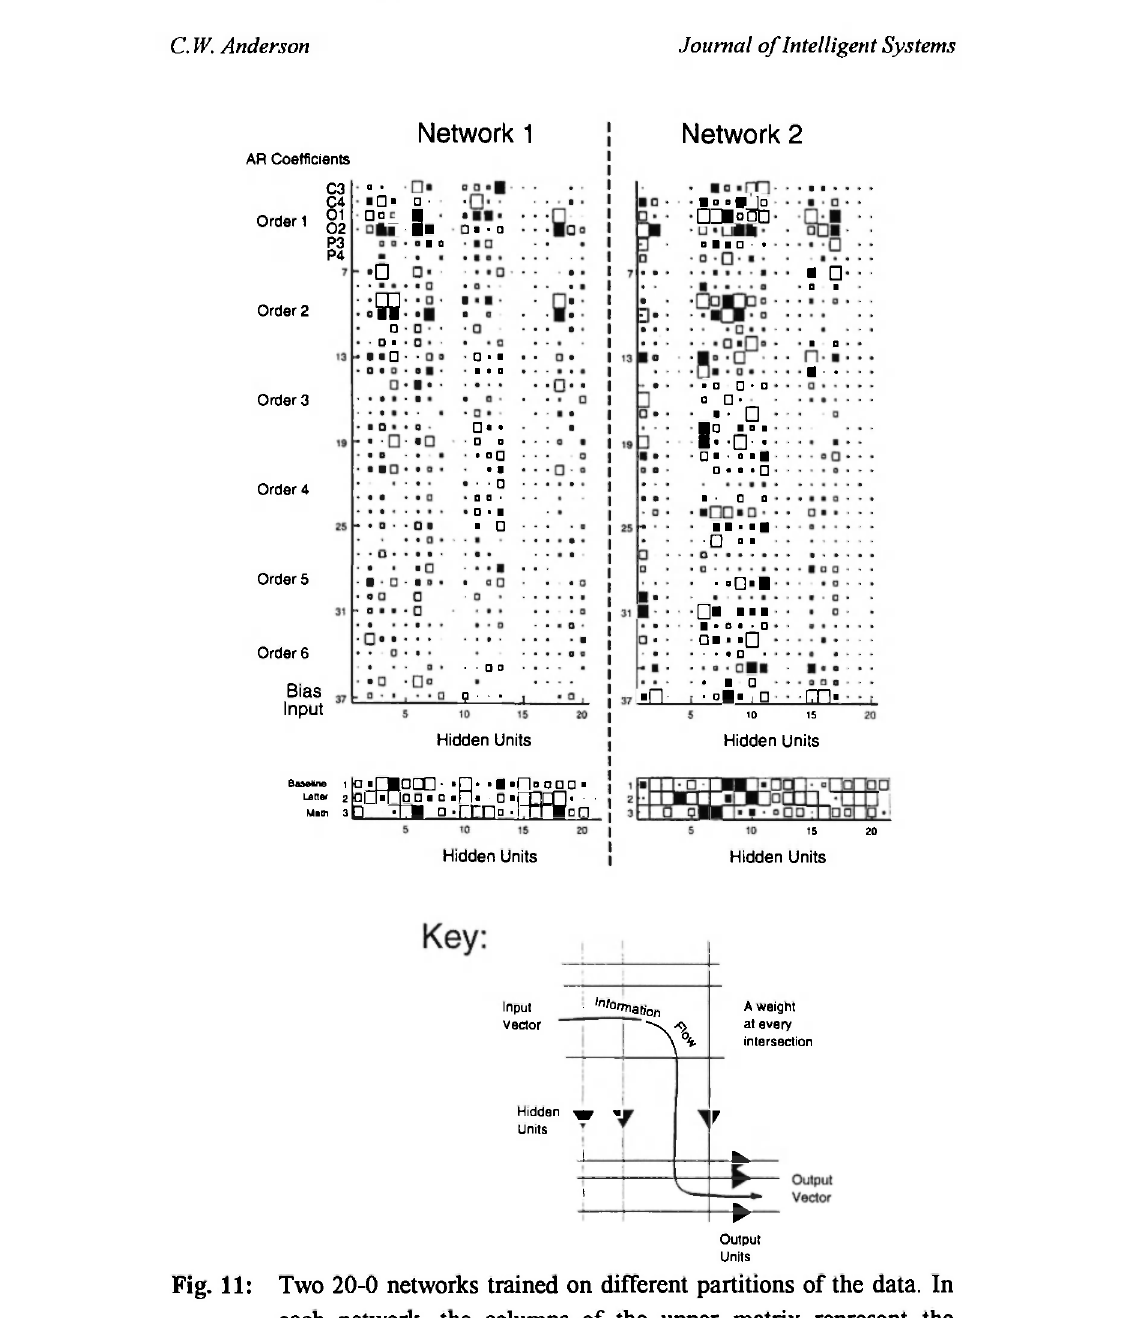
Fig. 11: Two 20-0 networks trained on different partitions of the data. In each network, the columns of the upper matrix represent the weights in each hidden unit and the rows of the lower matrix represent the weights in each output unit. Positive weights are filled, negative weights are